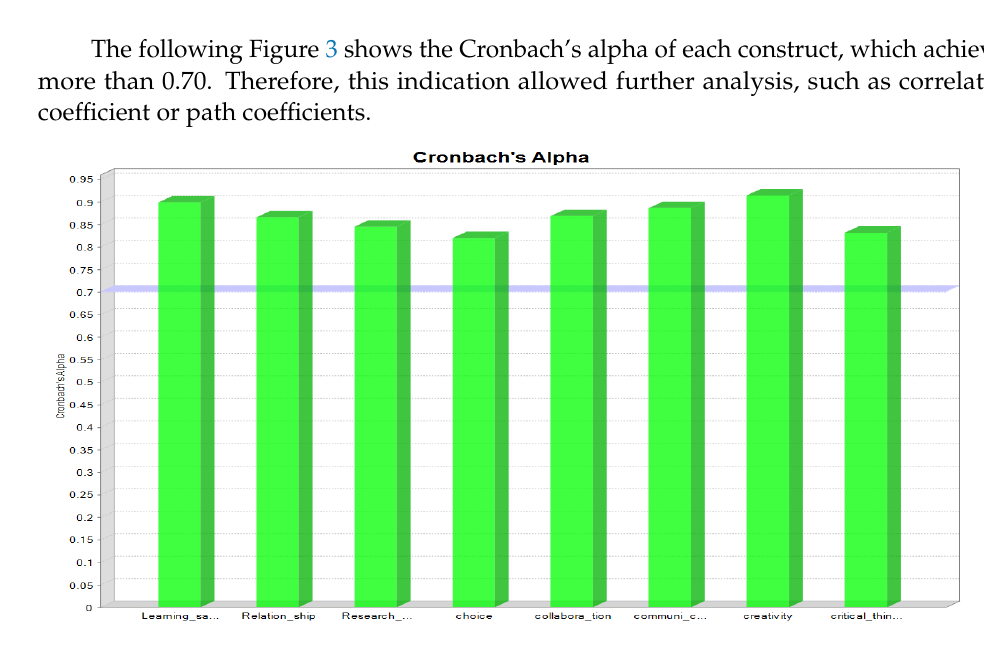
Figure 3. Cronbach’s Alpha of Constructs. Source: Empirical data analysis by Smart PLS [40].